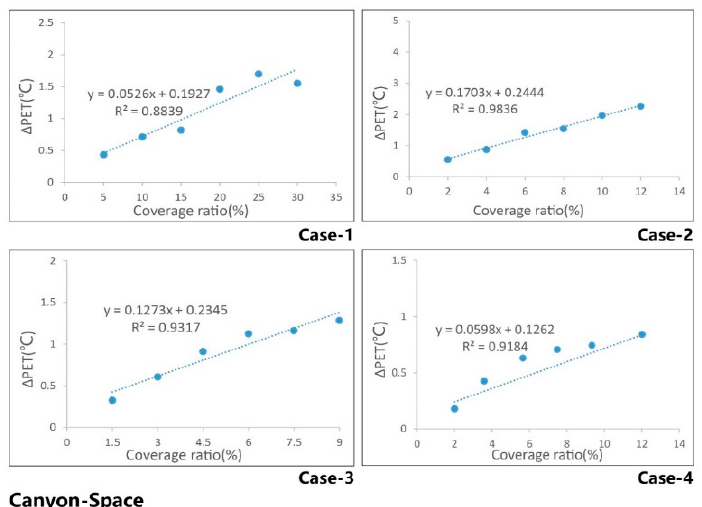
Figure 21. Correlation between thermal comfort and the coverage ratio of different parameters in canyon space at 14:00.